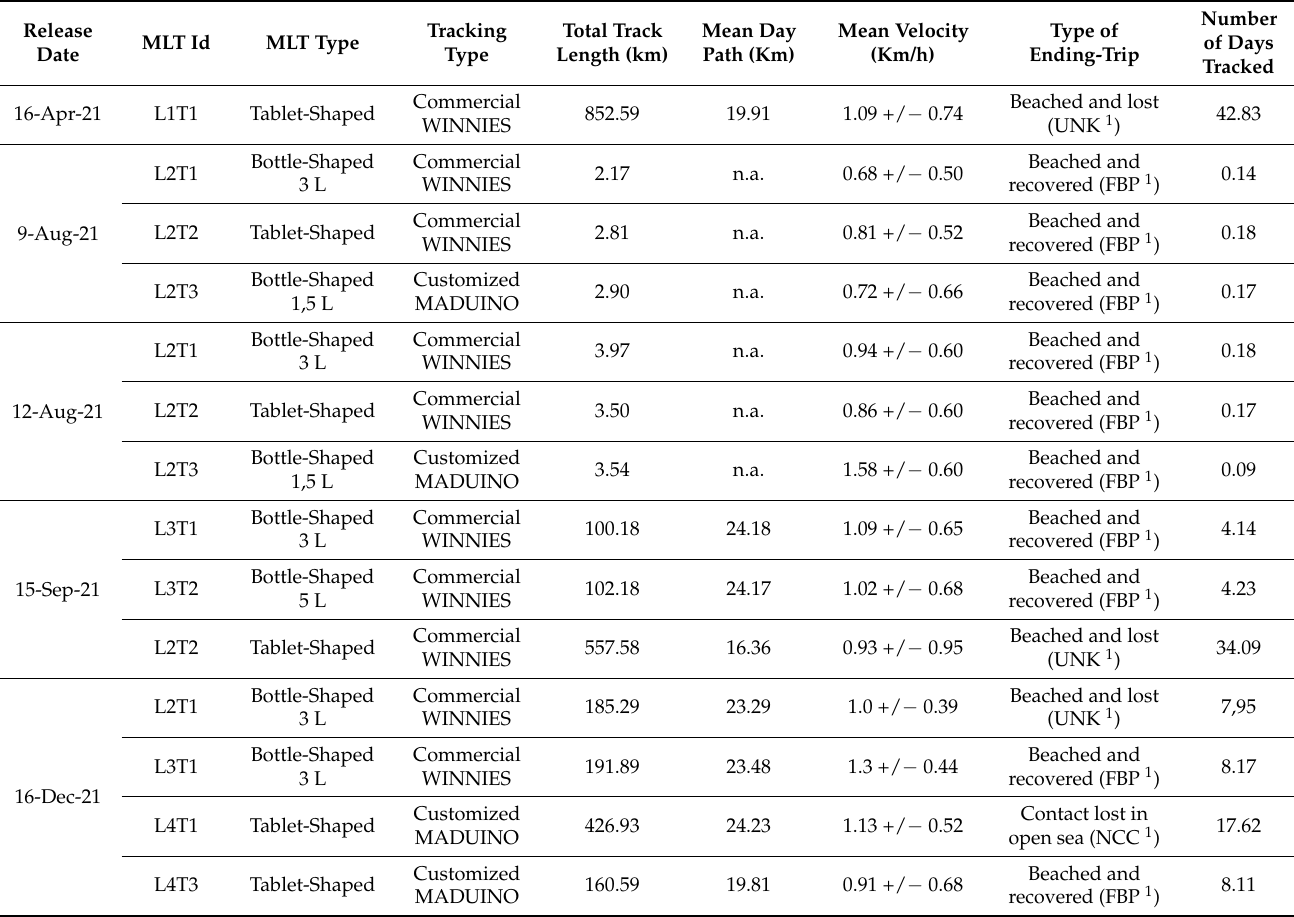
Table 1. All launches but the first were performed with 3 to 4 drifters at a time. The prototypes had different shapes (tablet, plastic bottles with 2, 3, and 5 liters volume), and with tracking cards of both the commercial-type and the customized-type. Launch coordinates: latitude 43.68202 ◦ , longitude 10.26484 ◦ (with uncertainty of 0.005 ◦ on both the coordinates). Hour of release: 11:00 CET/CEST (uncertainty of 25 min) for all launches except for the one in September, which started at 19:02